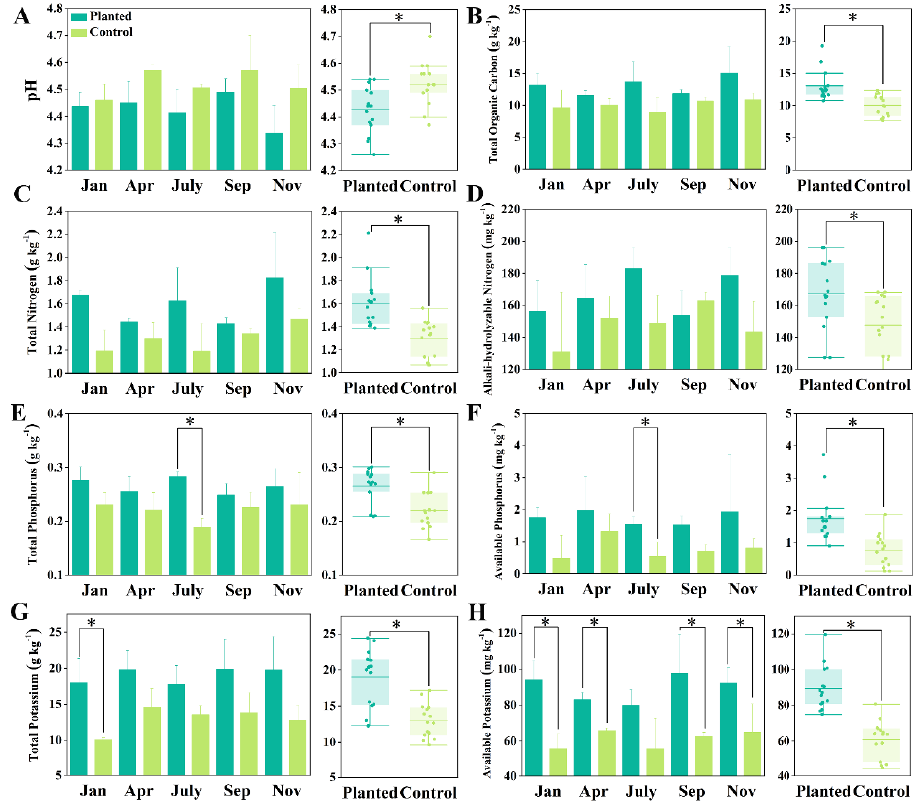
Figure 2. The annual variation in the soil pH and basic nutrients. The star marker indicates significant differences between the two groups (one-tail T -test, p < 0.05), and the error bar indicates the standard deviation ( n = 3 in the left part and n = 15 in the right part of subfigure ( A – H )).